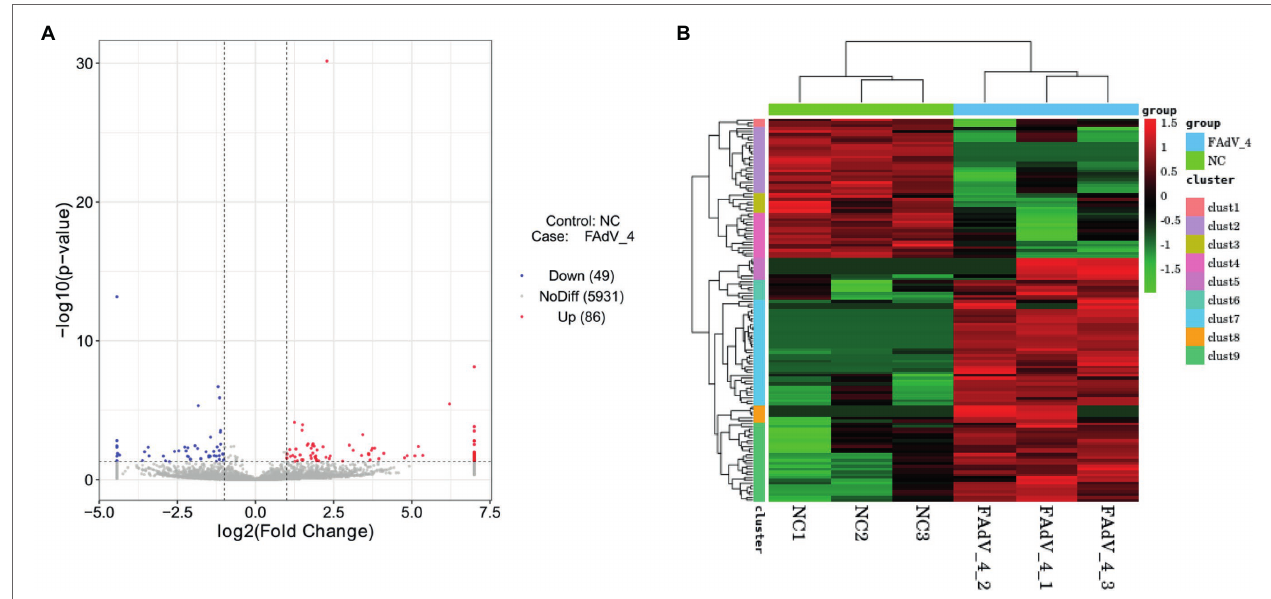
FIGURE 3 | Analysis of differentially expressed circRNAs. (A) The volcano map in Negative Control groups compared to FAdV-4 groups. The red dots correspond to upregulated circRNAs, the blue dots correspond to downregulated circRNAs and the gray dots represent the circRNAs without statistically significant difference. The vertical gray lines represent 2.0-fold up and down, and the horizontal gray line correspond to a p < 0.05 (B) Heat map for differentially expressed circRNAs from the control groups compared to FAdV-4 groups based on RPM of RNA-seq data (log2 scale). Clustering map shows the differential expression profile of circRNAs among different groups.